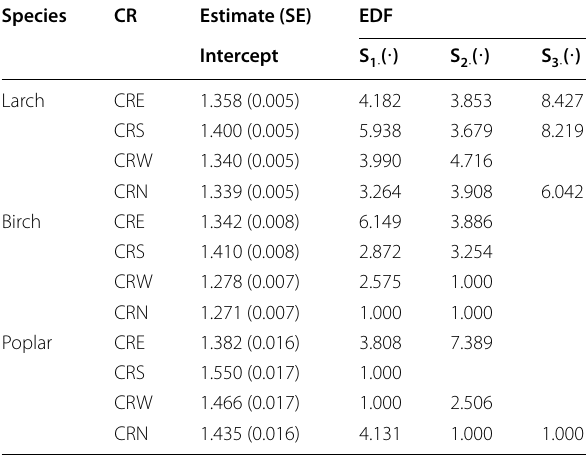
Note : SE standard errors, EDF effective degrees of freedom, and all parameters are significant at P 0.05